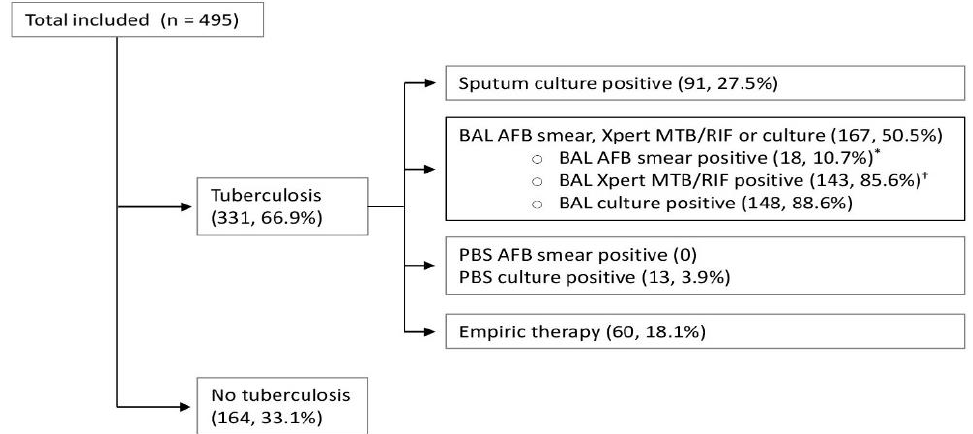
Figure 1. Cumulative diagnostic confirmation of pulmonary tuberculosis for patients who underwent bronchoscopic evaluation as part of their diagnostic work-up. * of which 18 were PCR-positive and 16 were culture-positive. † of which 124 were culture-positive. AFB, acid-fast bacilli; BAL, bronchoalveolar lavage.